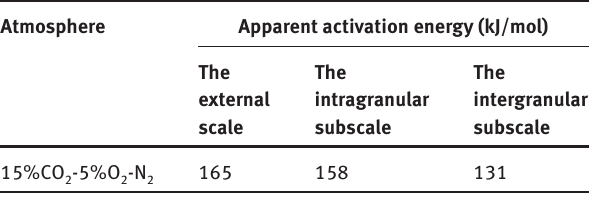
Table 2: Apparent activation energy for the growth of each scale in